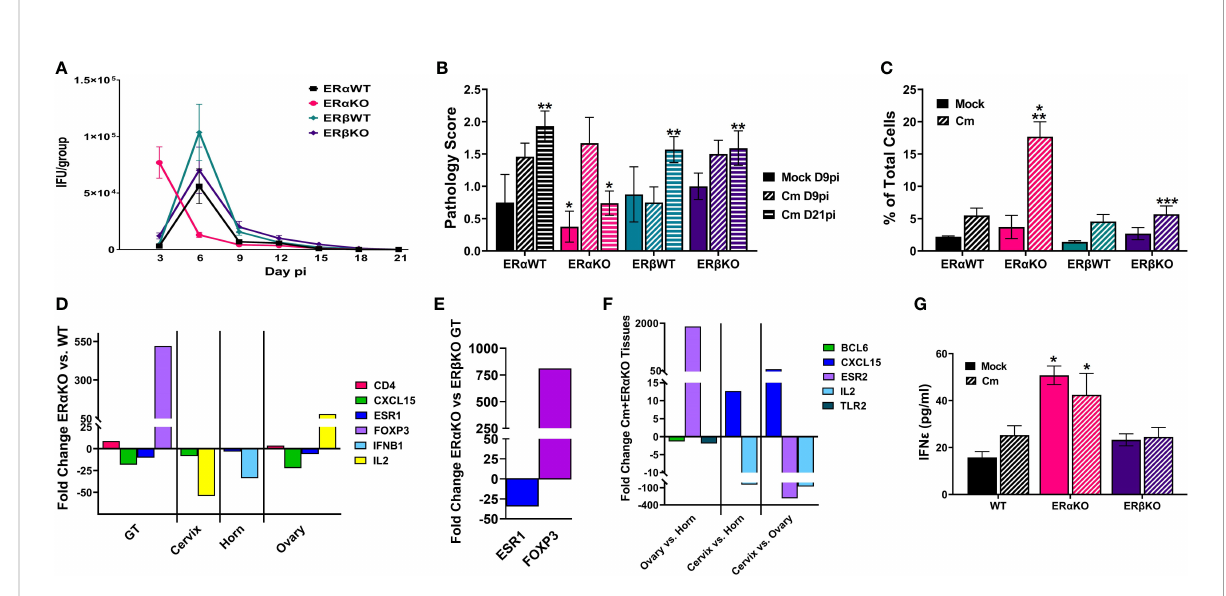
FIGURE 3 Estrogen receptors alter bacterial shedding, pathology, and the T cell response to C muridarum (Cm) in infected C57Bl/6 mice. (A) . EB shedding was monitored by chlamydial titer assays from C muridarum infected C57Bl/6 WT, ER a KO or ER b KO mice for 21 days pi. Data shown represent the average (n= 24 mice/group/day) IFU/group ± SEM. (B) . Gross genital tract pathology was assessed using the scoring criteria in Table 1 on day 9 or 21pi. Data shown represent the average pathology score ± SEM/group. (n=4-21mice/group/day) An asterisk (*) indicates signi fi cant difference from Cm-ER a KO D9pi, **Signi fi cantly different from Cm-ER a KO D21pi. (C) Flow cytometry analysis was performed to detect CD3 positive T cells in the genital tracts of mock or Cm-infected, hormone-treated OVT mice at day 9pi. Data shown represent the average (n=12 mice/group) percentage of total cells measured ± SEM. Asterisks indicate signi fi cant differences (P ≤ 0.05). *Cm vs mock, **ER a WT Cm vs Cm group, ***ER b WT Cm vs Cm group. (D-F) . Fold changes in expression of genes determined to be signi fi cantly different using the CLC Bio Genomics Workbench RNAseq deferential expression analysis tool. (D) . Comparisons between Cm-infected ER a KO and WT whole genital tracts (GT), or cervix, horn and ovary tissues. (E) . Comparisons between Cm-infected ER a KO and ER b KO GTs. (F) . Comparisons between Cm-infected ER a KO cervix, horn and ovary tissues. (G) . The concentration of IFN ϵ detected in vaginal swab samples on day 3pi by ELISA. Data shown represent the average (n= 4-9 mice/group) IFN ϵ concentration ± SEM. Asterisks (*) indicate signi fi cant differences between Cm and mock infection (P ≤